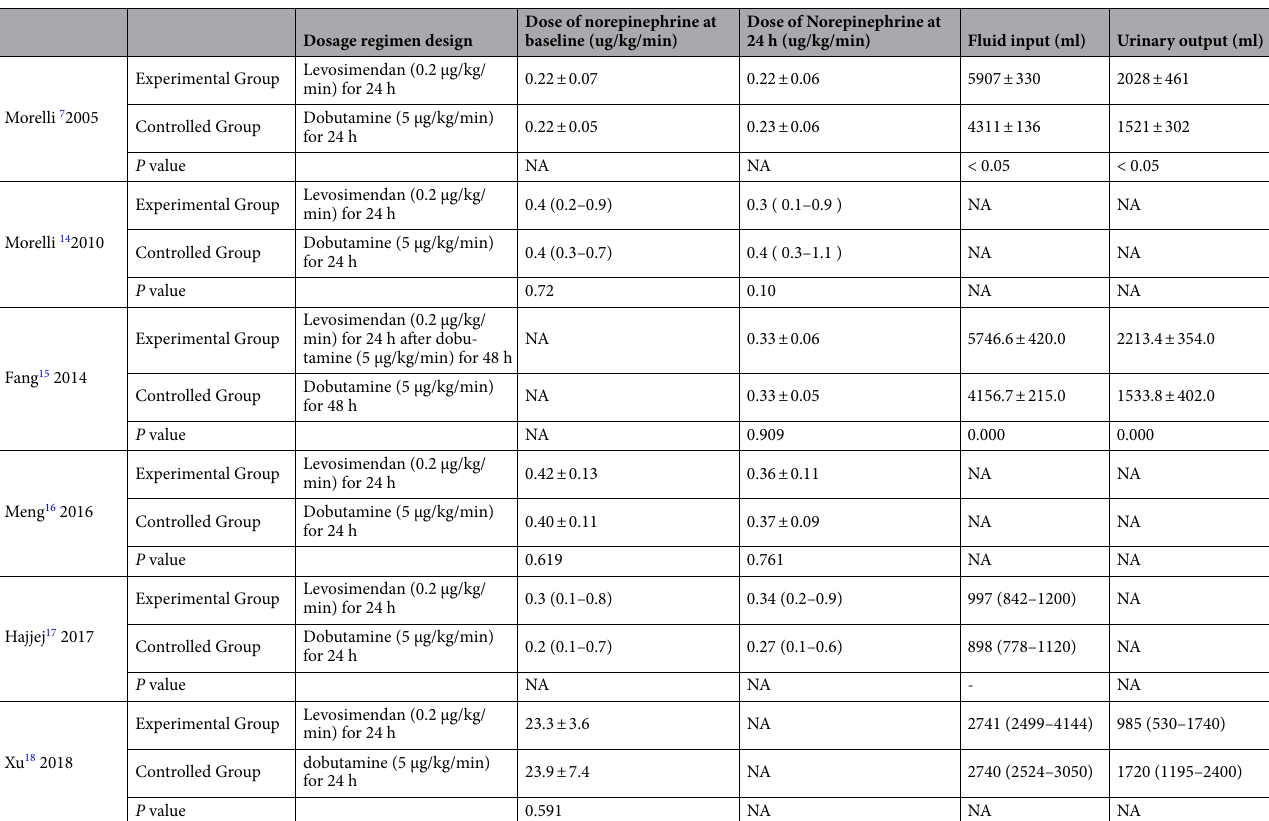
Table 4. Some relevant data between the experimental and the controlled group in the included literature. NA Not available in the included